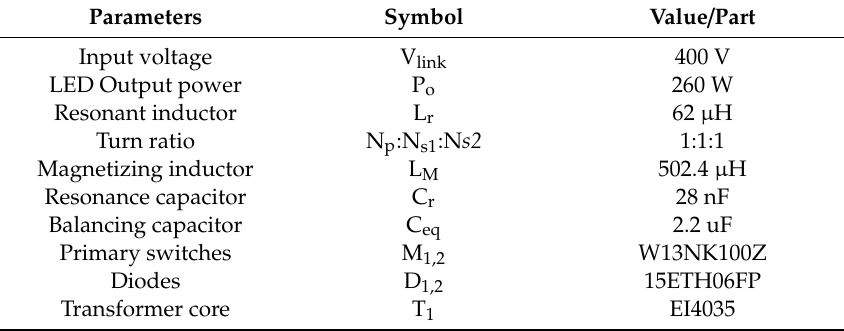
Table 2. Specific Components of